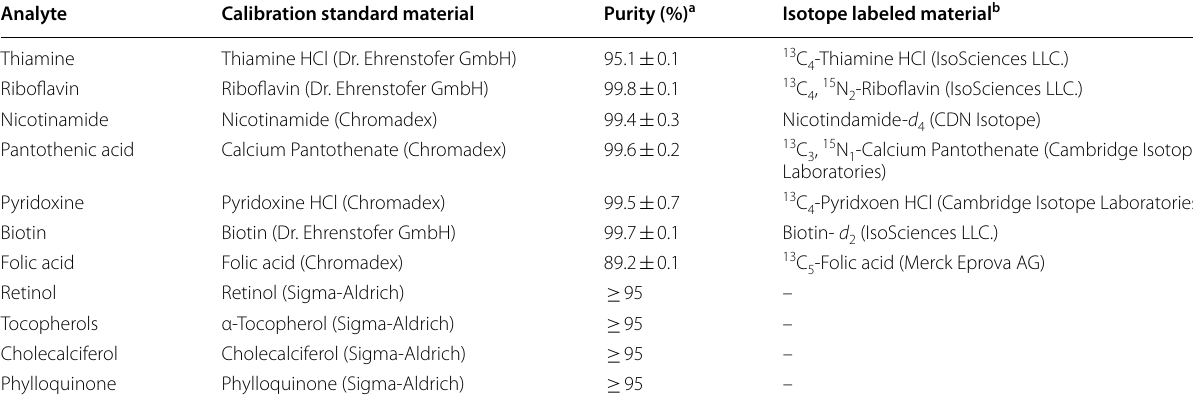
a Purity assay was performed by mass balance method for 7 WSVs including thiamine HCl, riboflavin, nicotinamide, calcium pantothenate, pyridoxine HCl, biotin and folic acid. Purities of retinol, α-tocopherol, cholecalciferol and phylloquinone were based on the manufacturer’s certificates b Isotope labeled materials were utilized an internal standard for IDMS method for certification of 7 WSVs